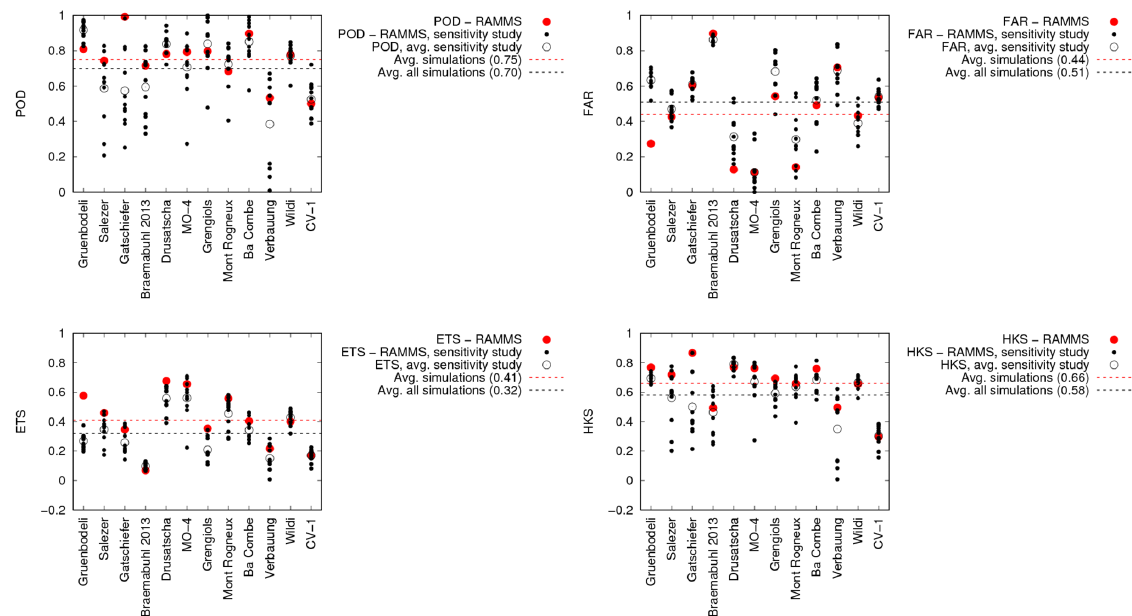
Figure 9. Sensitivity study simulating every avalanche path with the 12 different initial and boundary conditions, but with a simulation resolution (grid size) of 5m for the 144 simulations (compare to Fig. 5 for 3m resolution). Markers and colors as in Fig. 5.